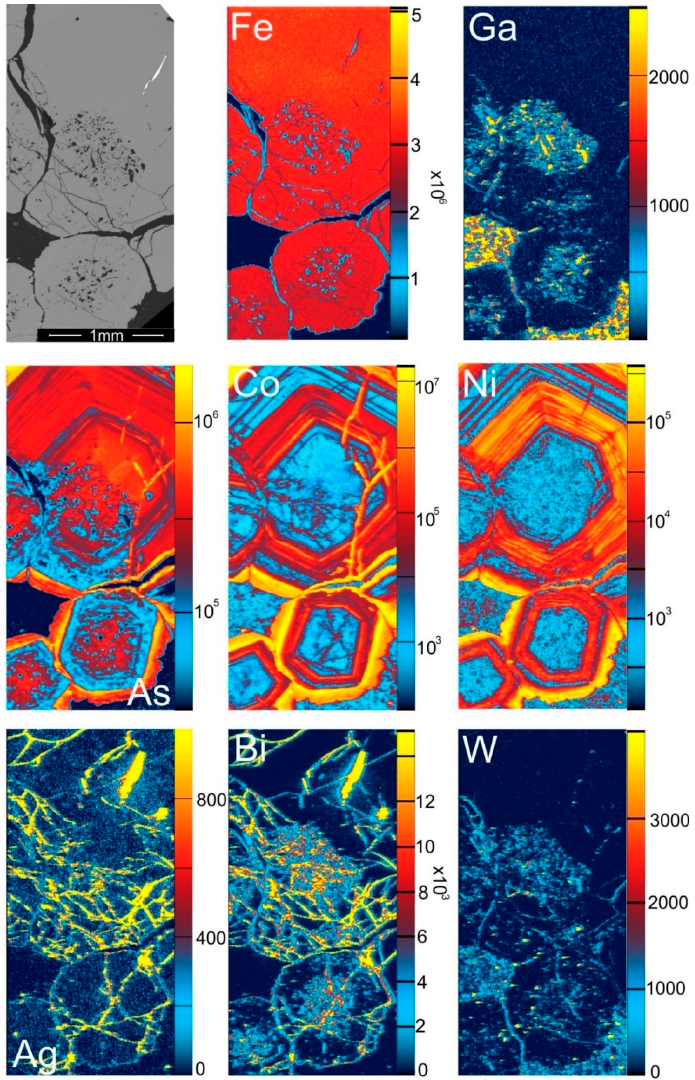
Figure 1. LA ‐ ICP ‐ MS maps of mm ‐ sized pyrite grains displaying micron ‐ scale oscillatory zoning. Note that, whereas As, Co and Ni occur in solid solution, within the pyrite grains and display concentric zoning, the map for Ga shows that element associated with microscopic silicate inclusions in the pyrite cores, and the maps for Ag, Bi and W show these elements are distributed not within the zones but in crosscutting microfractures. The mapped area is shown as a backscatter electron image at upper left. Scales in counts ‐ per ‐ second. Measured isotopes: 56 Fe, 69 Ga, 75 As, 59 Co, 60 Ni, 109 Ag, 2095 Bi, 182 W.